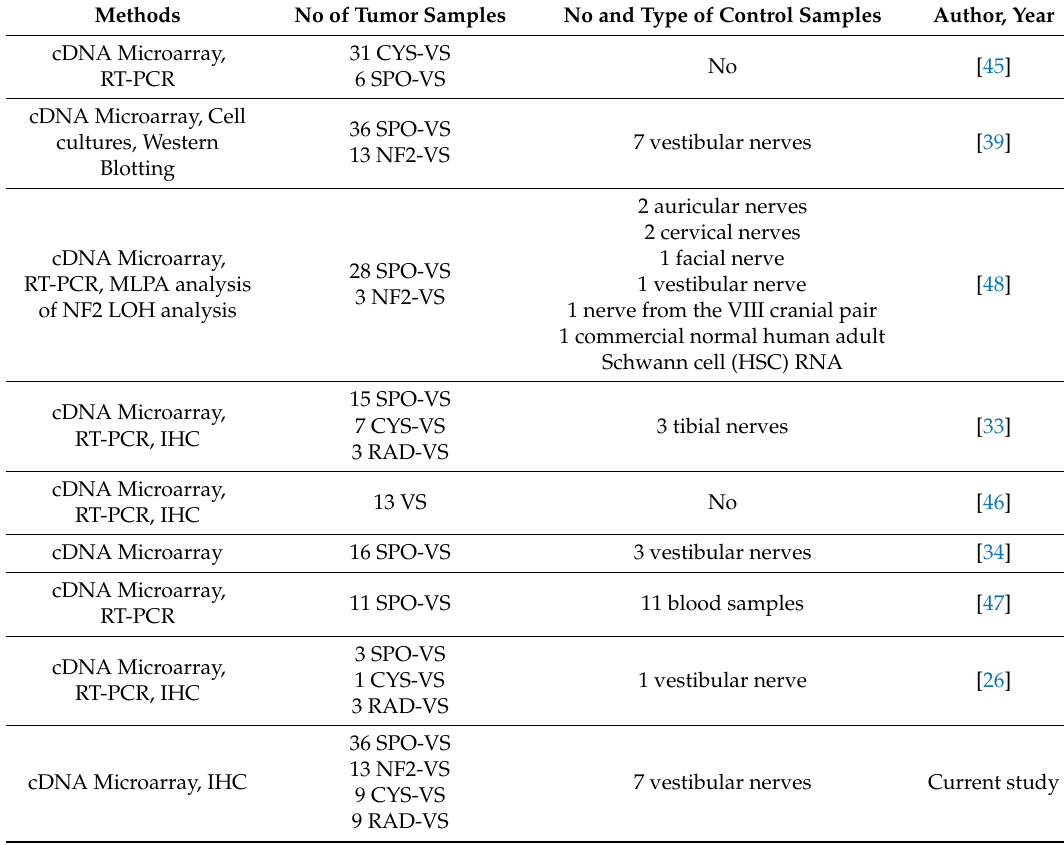
Table 3. cDNA Microarray analysis in the field of vestibular schwannoma